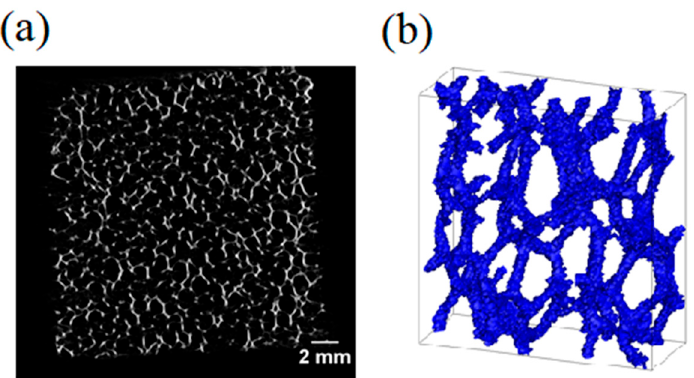
Figure 1. Setup for measurements on the hydrodynamics of a droplet passing through a metal foam. 2.2. Metal Foam Micro-Tomography